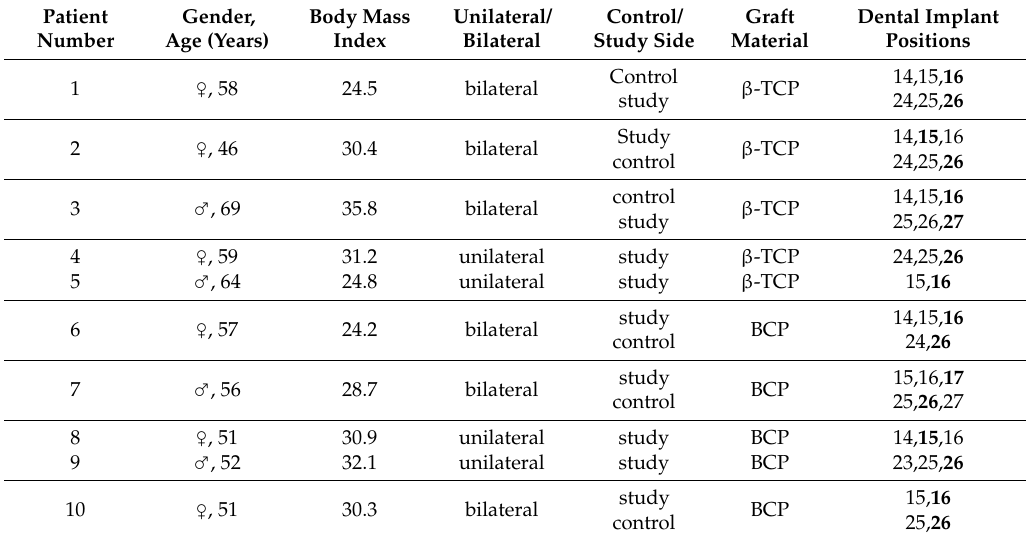
Table 1. Patient demographics (as published earlier in [27]) showing gender and age (years), body mass index, whether the patients were treated unilaterally or bilaterally (“split-mouth design”), type of calcium phosphate bone substitute used for the maxillary sinus floor elevation procedure, and the dental implant sites according to the F é d é ration Dentaire Internationale (FDI) system. Selected biopsies are displayed in bold. β -TCP, β -tricalcium phosphate; BCP, biphasic calcium phosphate. Patient Gender, Body Mass Unilateral/ Number Age (Years) Index